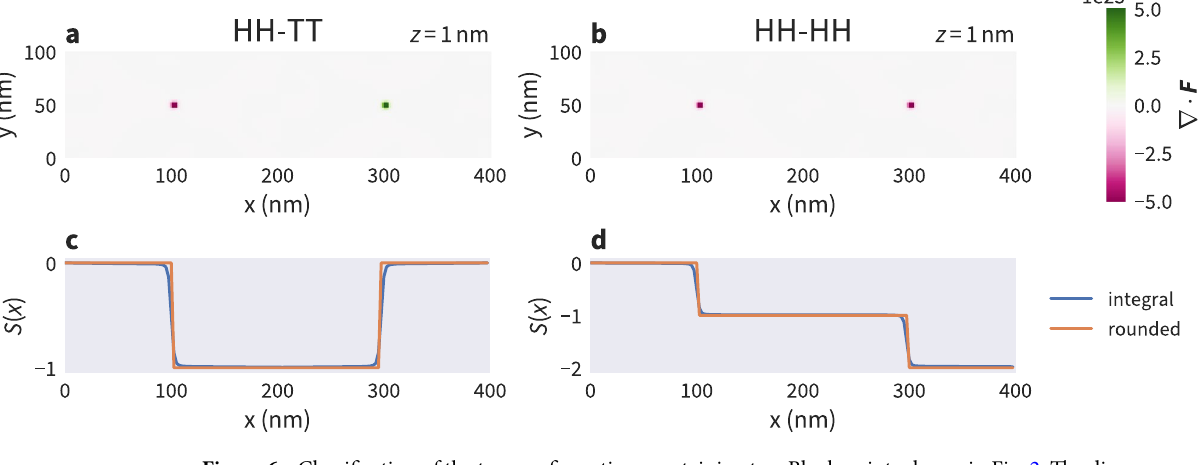
Figure 6. Classification of the two configurations containing two Bloch points shown in Fig. 2. The divergence of the emergent magnetic field for the two opposite- and same-type Bloch points is shown in panels ( a ) and ( b ), respectively. The xy plane visualised here is located at z = 1nm , just above the interface. ( c , d ) The result of the convolution (5) which is used to identify the occurrence of Bloch points and their type due to the steps (cid:31) S = ± 1